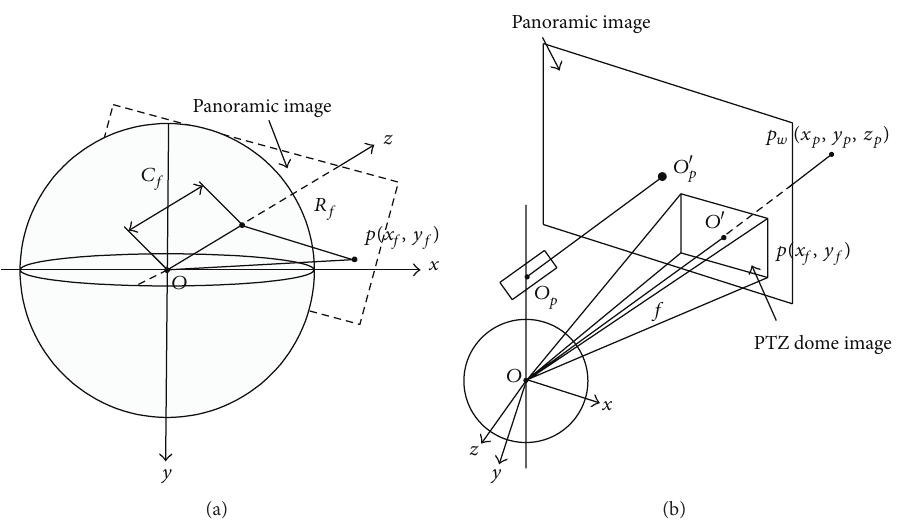
Figure 5: (a) PTZ image coordinate system imaging and (b) PTZ camera’s